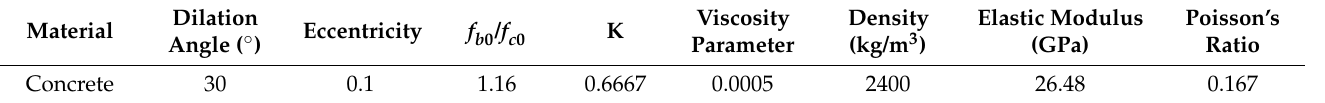
Table 1. Parameters of concrete